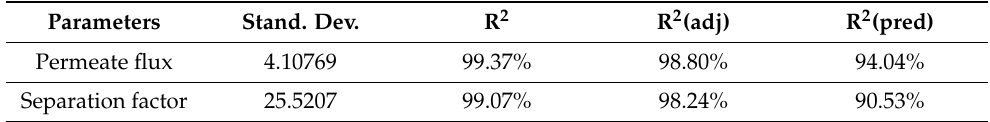
Table 5. Model summary for toluene permeate flux and separation factor.